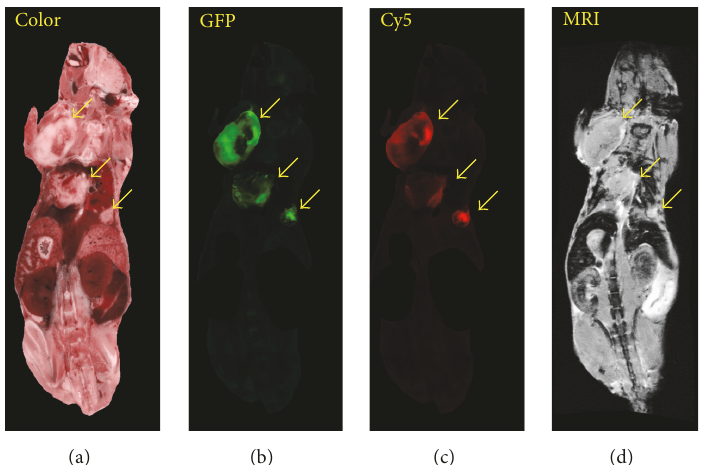
Figure 9: Multimodality analysis of large metastases targeting. From left to right are color episcopic anatomy, green fluorescence GFP tumor, red fluorescence CREKA-Cy5, and MRI CREKA-Gd. Large tumors (arrows) visible in bright field and GFP images are labeled in Cy5 and MRI images. In these images, we masked out the GI tract and skin, which tend to have a lot of auto fluorescence. The imaging agents tend to label the edges of bigger metastases and all of smaller